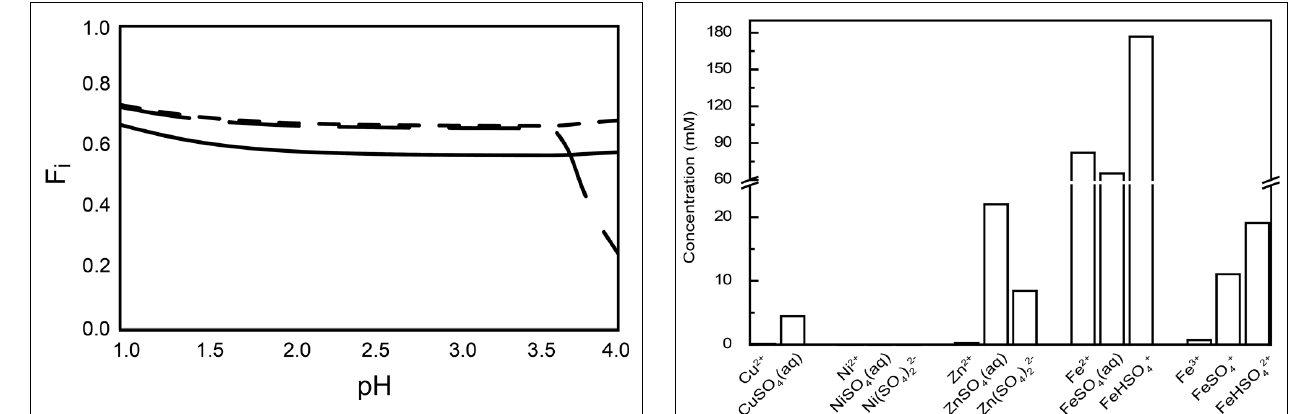
FIGURE 2 |The aqueous metal speciation in Iron Mountain, California. The concentrations of free metal ions and metal speciation by sulfate are calculated assuming the composition of sample 90WA103 from the Richmond Mine, Iron Mountain (Nordstrom and Alpers, 1999) at pH 0.48. A temperature of 25 ◦ C is assumed in the calculations and other metal concentrations are considered to be